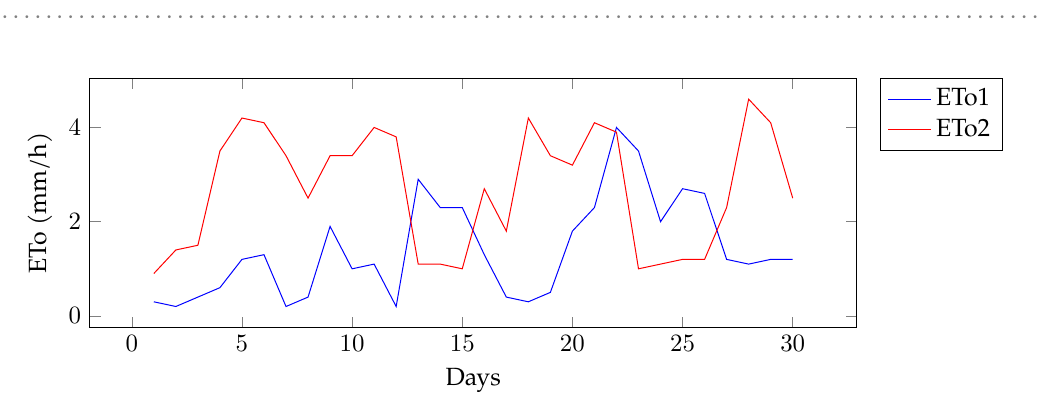
Figure 9: Experimental data